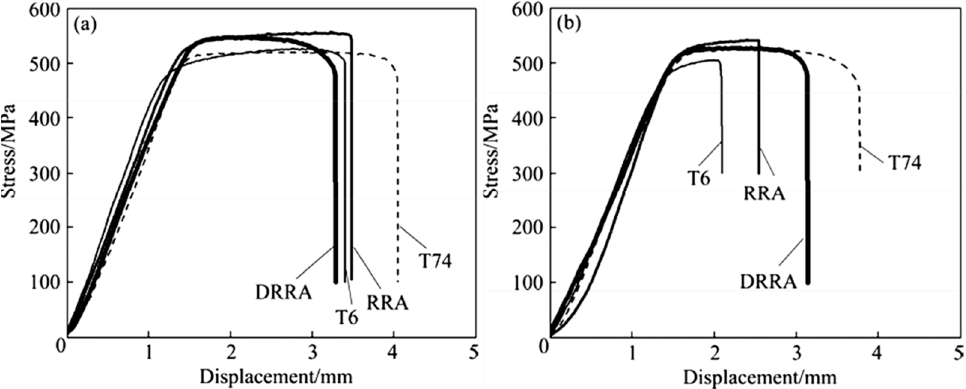
Figure 20. SSRT results of AA7085 under different aging regimes ( a ) in air ( b ) in 3% NaCl solution. (Reprinted with permission from ref. [41]. Copyright 2014 Elsevier).